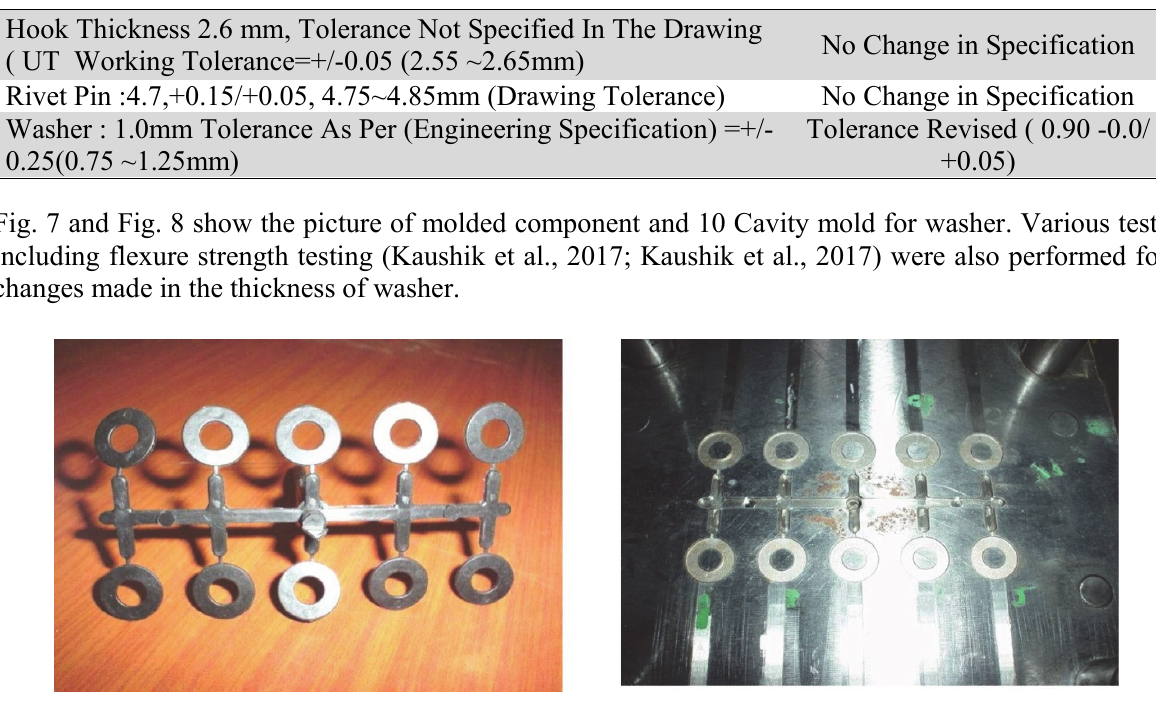
Fig. 7. Molded Component Fig. 8. 10 Cavity Mold